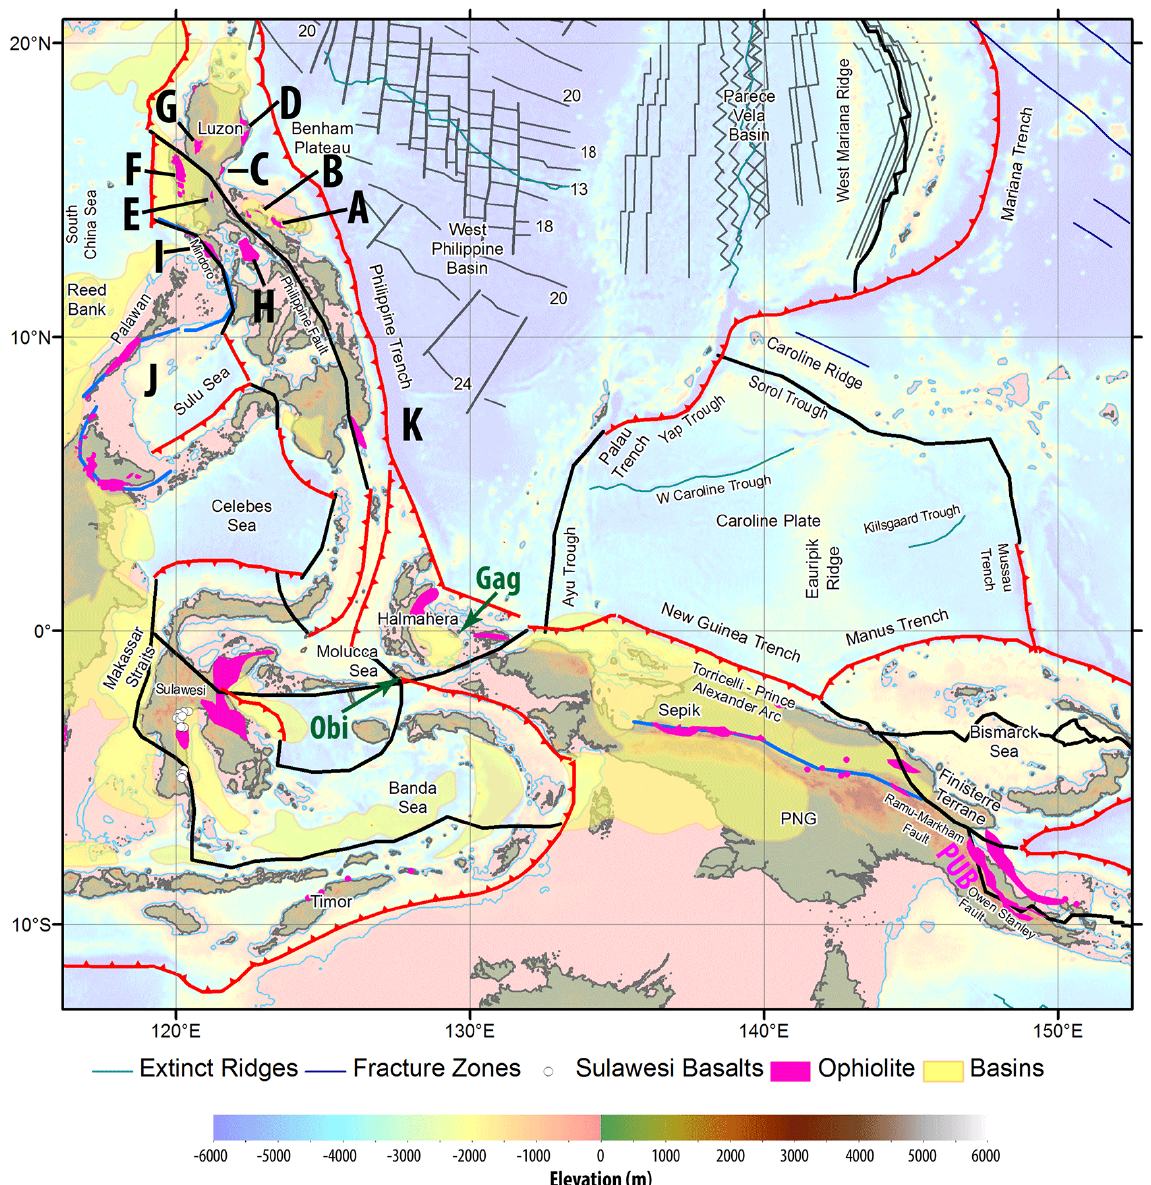
Fig. 1b. Regional tectonic setting of the Philippine Sea plate, Papua New Guinea and the Caroline Plate, following symbology of Fig. 1. The crystallization ages of ophiolites were used to infer oceanic crust age, while the metamorphic age was used to infer collision and